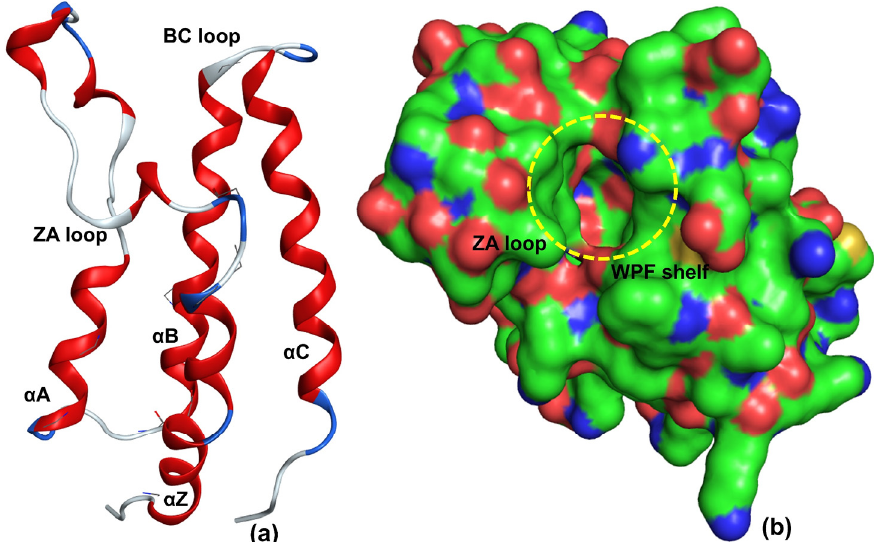
Figure 1. X-ray resolved structure of BRD-4 using pdb 5UVT ( a ) without molecular surface and ( b ) with molecular surface (green: carbon; red: oxygen; blue: nitrogen).